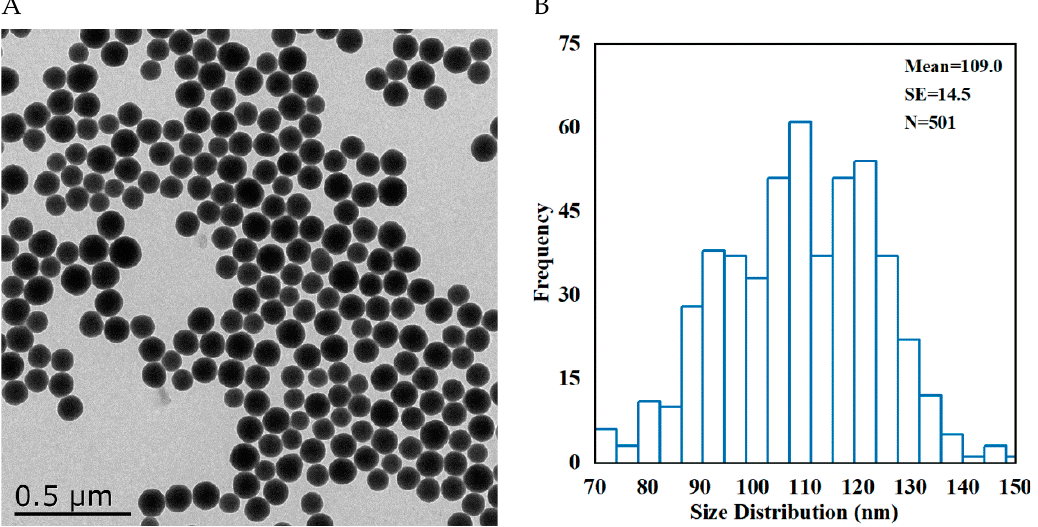
Figure 1. The morphology and size of SNPs. ( A ) Representative TEM image of spherical SNPs. Scale bar, 0.5 µm. ( B ) Distribution diagram of SNPs in A .